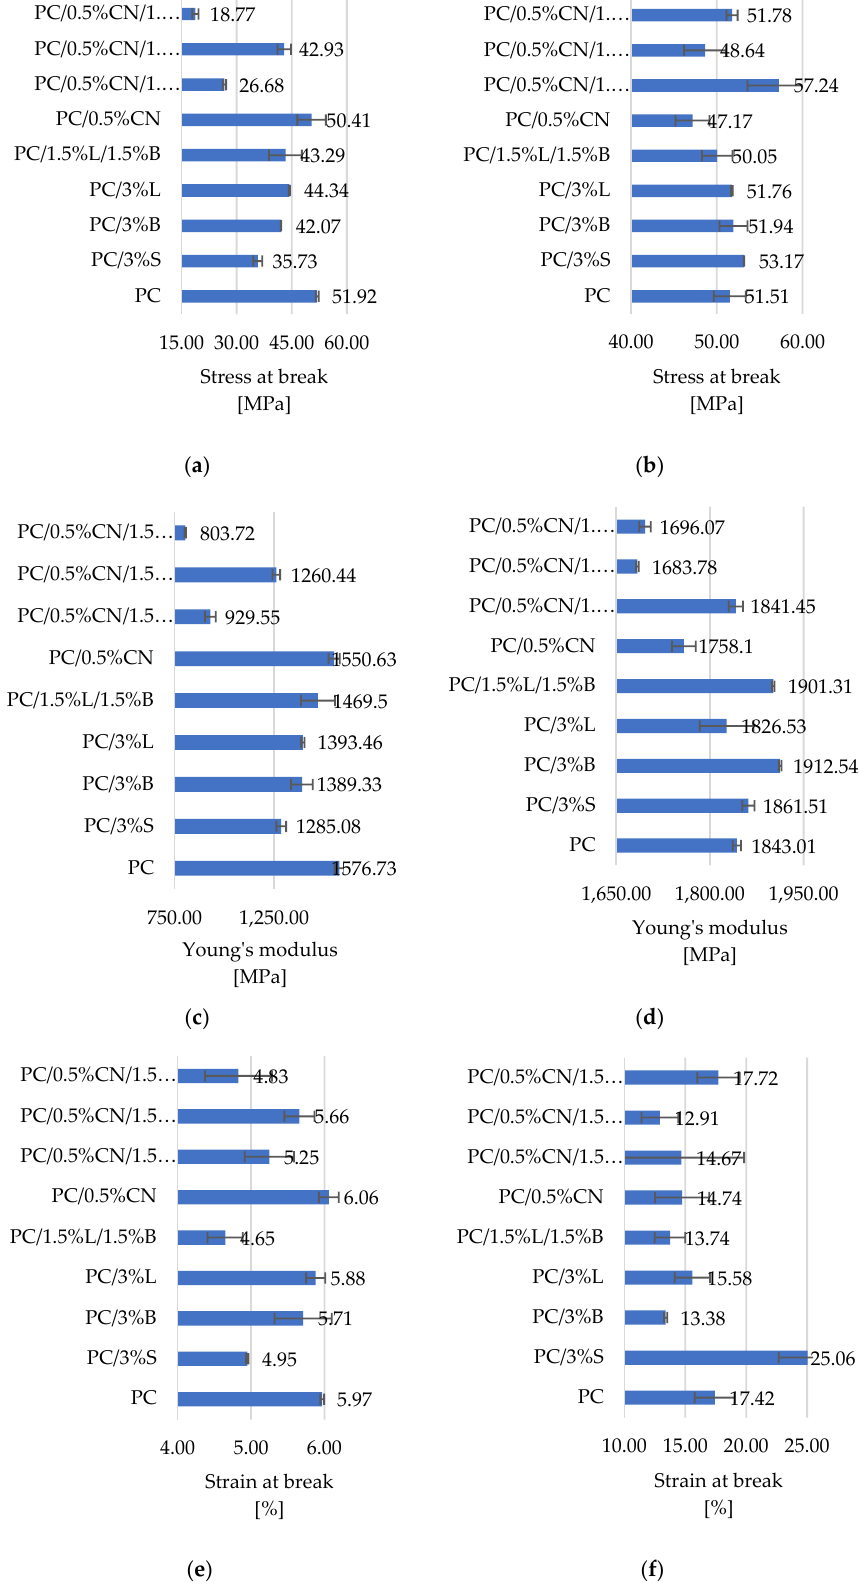
Figure 8. Results of static tensile strength tests: stress at break ( a ) samples obtained by 3D printing, ( b ) samples obtained by injection molding, Young’s modulus ( c ) samples obtained by 3D printing, ( d ) samples obtained by injection molding, strain at break ( e ) samples obtained by 3D printing, ( f ) samples obtained by injection molding.